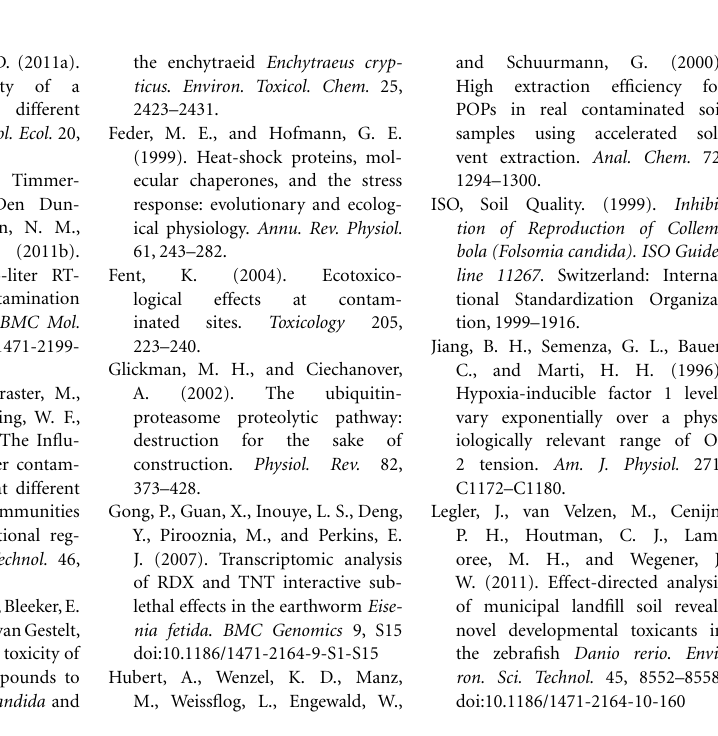
Table S1 | Measurement of metals and soil parameters in threeVlagheide samples. Table S2 | Log2 normalized gene expression values from biological replicates in the QPCR assays. SampleTypeSign, heat map significant genes factor SampleType (extract or soil). TreatmentSign, heat map significant genes factor Exposure level (NOEC or DiR). InteractionSign, heat map significant genes SampleType × Treatment